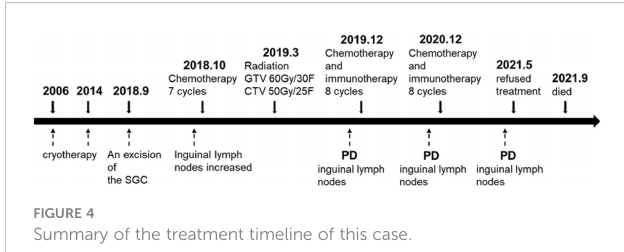
FIGURE 4 Summary of the treatment timeline of this